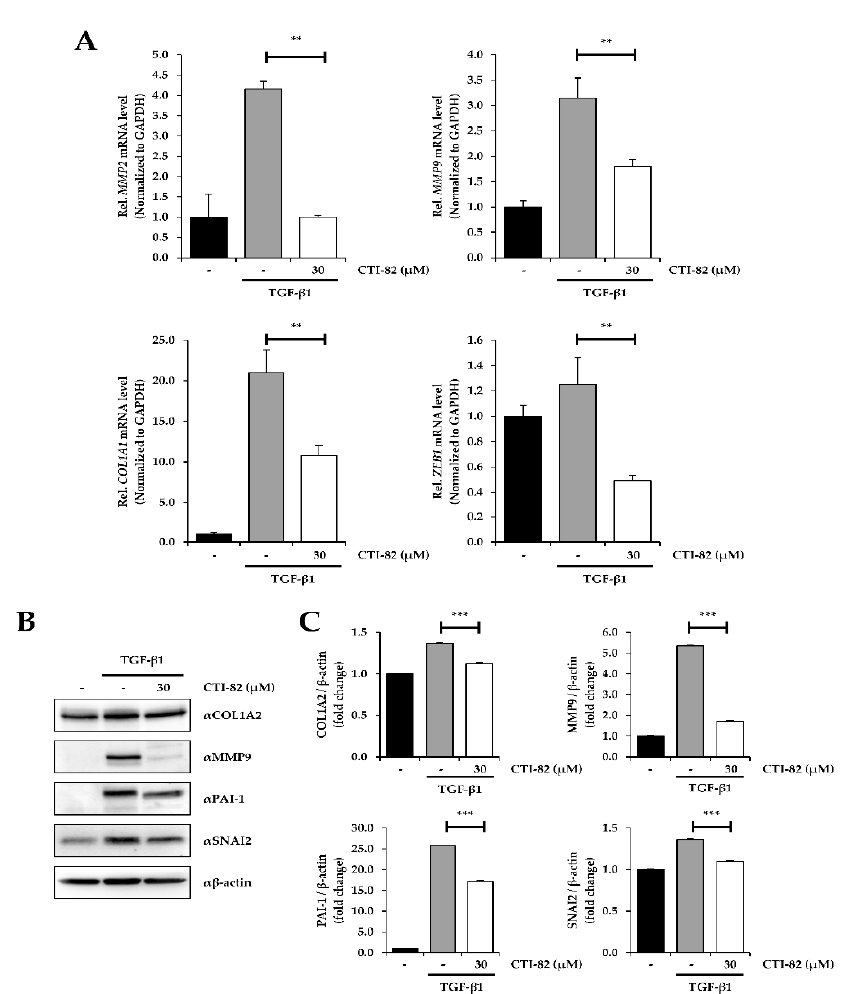
Figure 5. E ff ect of CTI-82 on TGF- β 1-induced EMT-related gene expression. ( A ) Expression of matrix metalloproteinase-2 (MMP2), MMP9, COL1A1, and ZEB1 mRNA. CTI-82 regulates the expression of EMT-related genes induced by TGF- β 1. A549 cells were treated with TGF- β 1 (5 ng / mL) alone for 2 h, followed by treatment with CTI-82 for 48 h. Using qPCR analysis, the expression level of the genes was analyzed and compared to the control group treated with TGF- β 1 alone. ( B , C ) Western blot analysis and densitometric quantification of E-cadherin, N-cadherin, COL1A2, MMP9, PAI-1, and SNAI2 in A549 cells. A549 cells were treated with TGF- β 1 for 2 h, followed by treatment with CTI-82 for 48 h. Western blot analysis was performed with cell lysates. *** p -value < 0.001, ** p -value < 0.01 versus TGF- β 1 alone. The data are expressed as the mean ± SD for triplicates. (The uncropped blots and molecular weight markers are shown in Supplementary Figure S1).